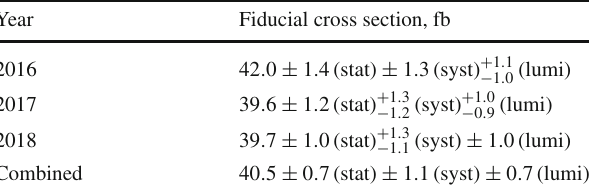
Table 3 Measured fiducial cross section for each data sample and com- bined. The first uncertainty is statistical, the second is experimental systematic, and the third is associated with the integrated luminosity